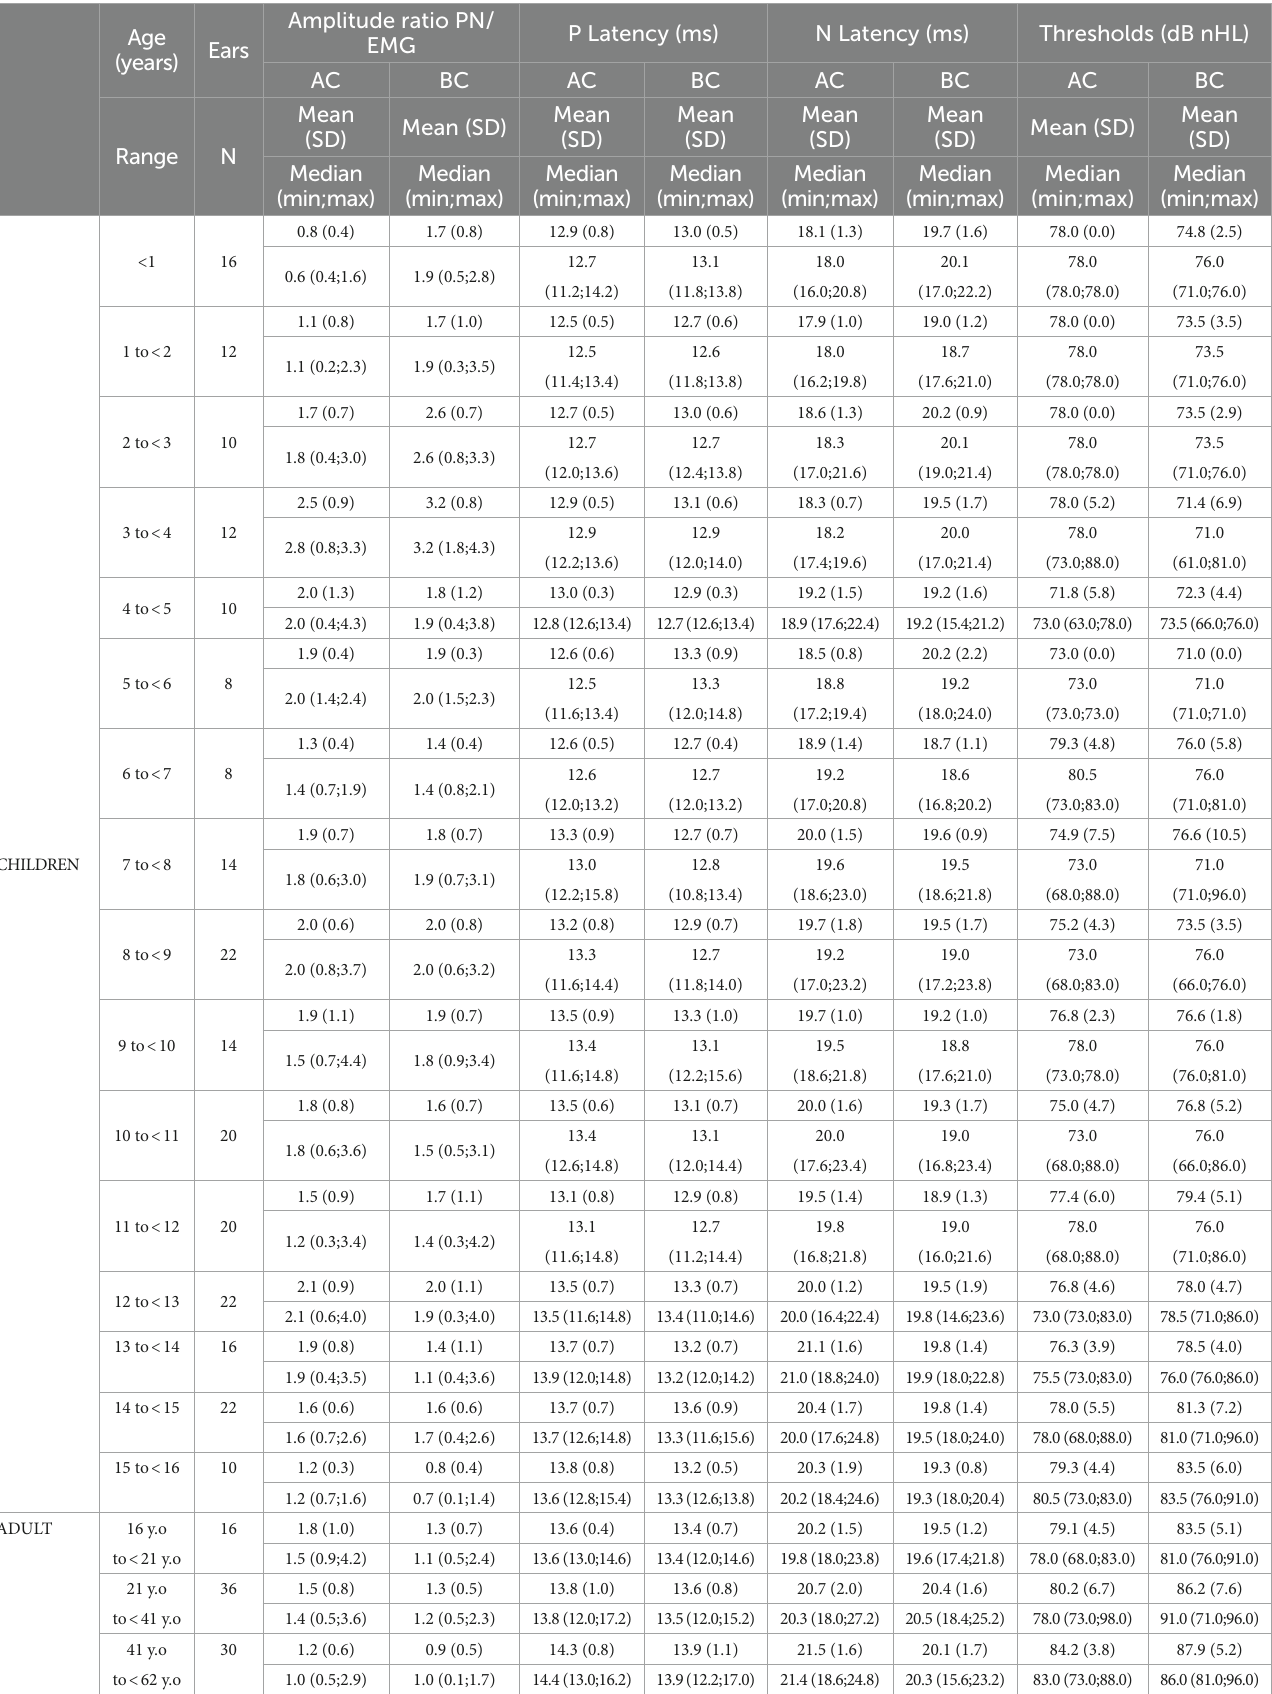
TABLE 2 c-VEMP characteristics (amplitude ratio, P- and N-wave latency, threshold) as measured in children and